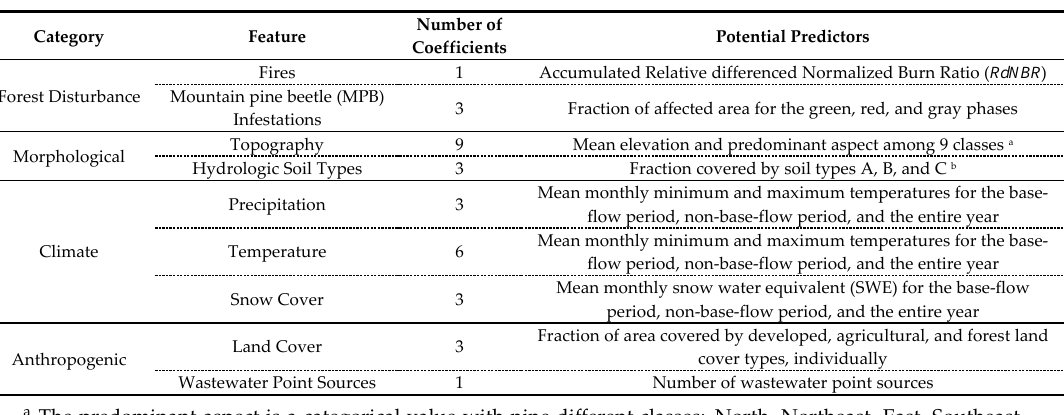
Table 1. Features potentially influencing carbon concentrations in the region of interest. Although Land Cover appears in the Anthropogenic category, it can also represent Forest Disturbance, as described in Appendix A. The potential predictors are used to represent the features in the model described in Section 3, in which each coefficient represents the strength of the relationship between the response variable (dissolved organic carbon (DOC)) and the predictor.